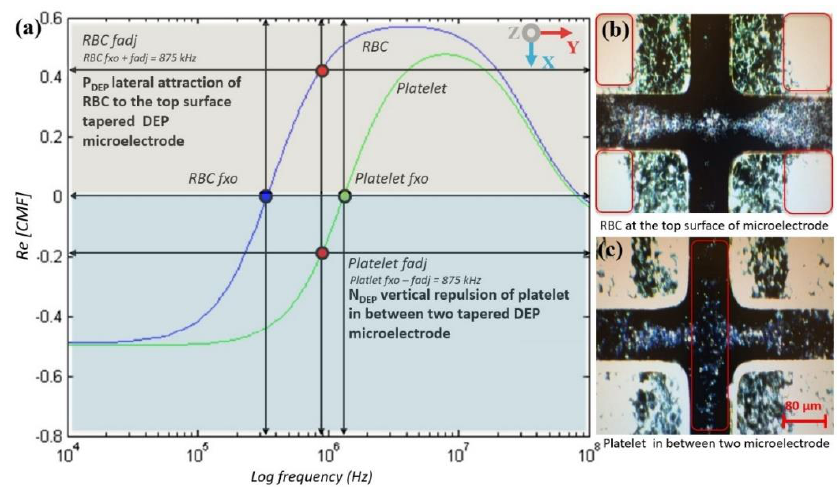
Figure 12. The CMF polarisation factor of the RBC and platelet zones.